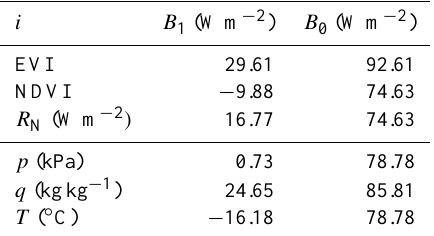
Table 8. Summary statistics of PT-JPL model inputs from field data versus Noah reanalysis data. B 1 and B 0 are the slope and inter- cept of the linear fit and N is the number of monthly samples. The statistics for Noah pressure and specific humidity were derived us- ing relative humidity from the